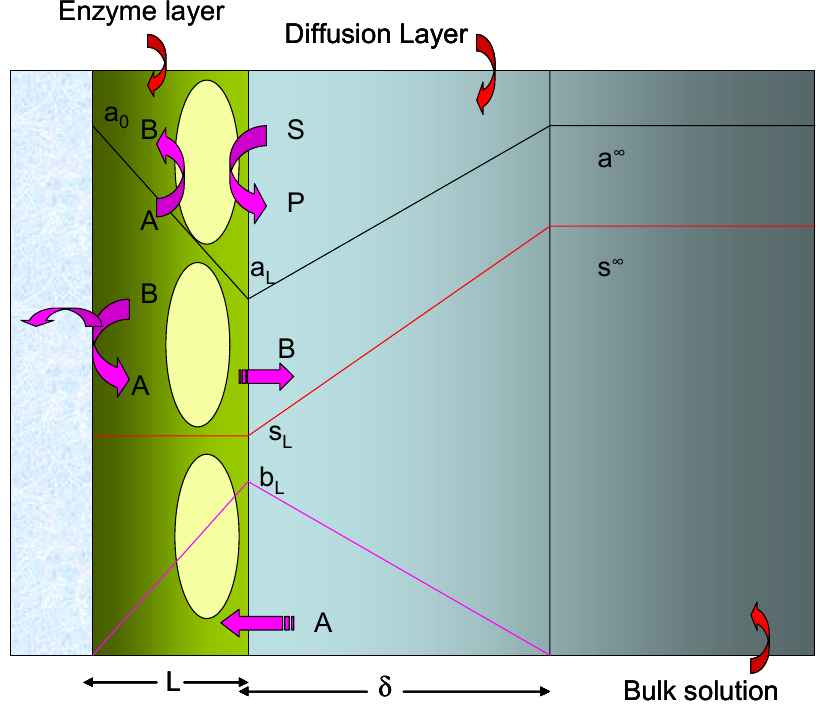
Figure 2. Schematic representation of immobilized enzyme electrode using a soluble redox mediator. A denotes the oxidized mediator, B is the reduced mediator. Concentration polarization of substrate S and mediator within the enzyme layer is neglected but a Nernst diffusion layer treatment for substrate and mediator transport in the solution is